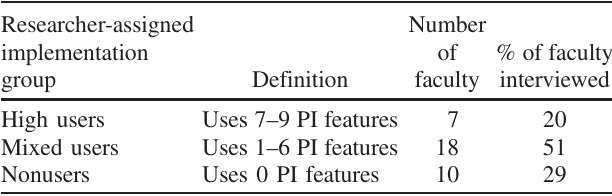
TABLE IV. Research-assigned PI implementation groups. Researcher-assigned